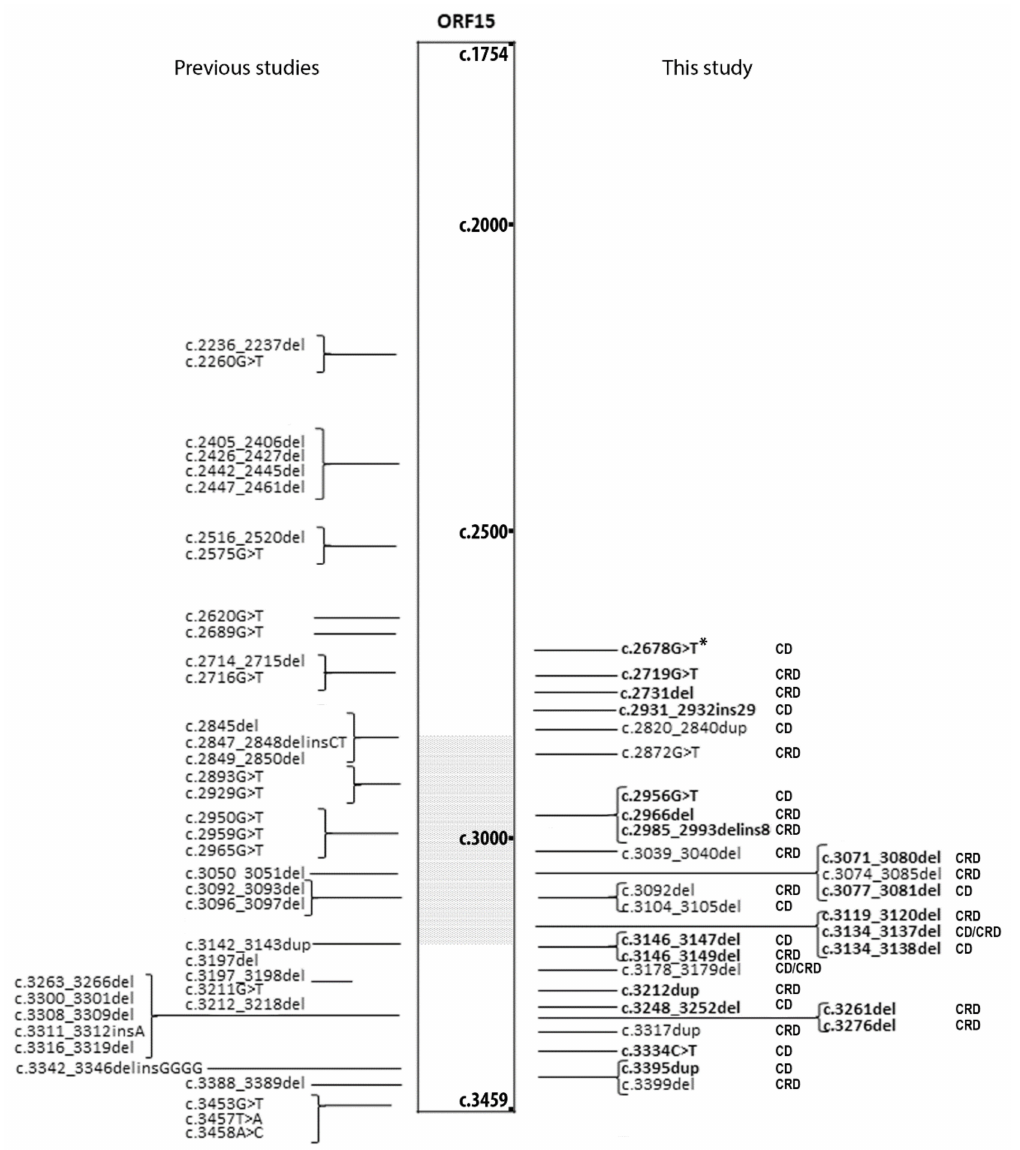
Figure 1. The list of RPGR ORF15 (NM_001034853.2) variants associated with cone or cone-rod dystro- phies (CDs or CRDs). Variants that have been previously published by other groups are depicted on the left. Variants reported in the present study are on the right with the associated phenotype. Novel variants are reported in bold. The grey dotted area corresponds to the “watershed zone” as approximately defined by De Silva et al. 10 . *: Variant c.2678G>T is a variant of unknown